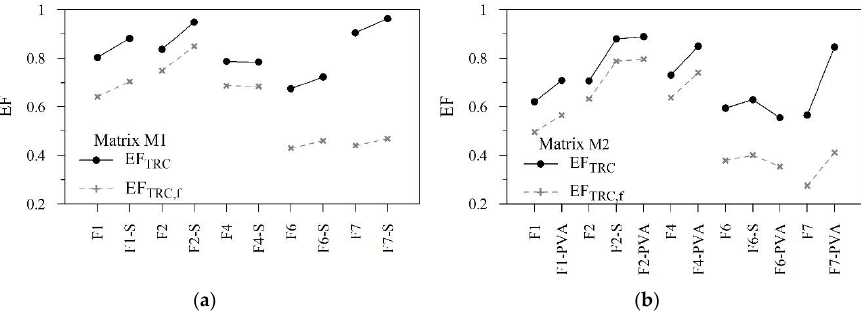
Figure 12. Efficiency factors in uniaxial tension for M1-based ( a ) and M2-based ( b ) TRC composites.